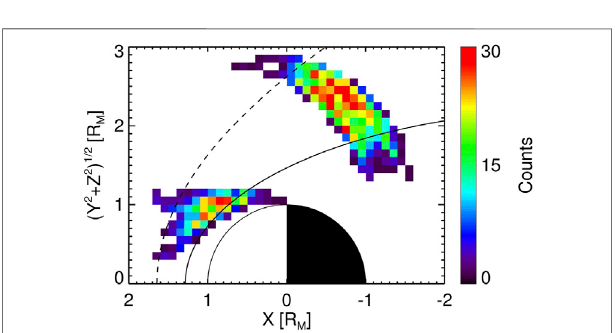
FIGURE 3 | Distribution of the orbit coverage shown in a cylindrical coordinate system. The bin size is 0.1 R M . The black solid and dashed curves indicate the induced magnetopause boundary and bow shock adopted from Vignes et al. (2000), respectively.